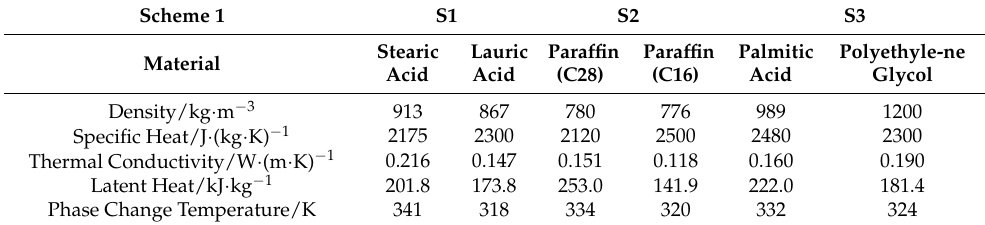
Table 1. Combination schemes of PCM for cascade storage units.